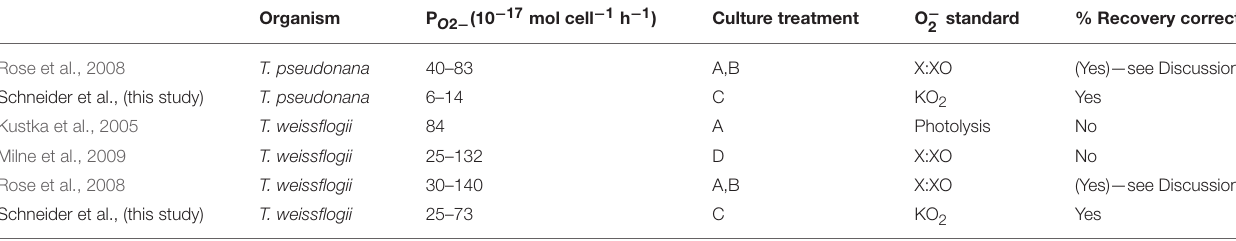
TABLE 3 | Comparison of published diatom P O 2 − and methods.